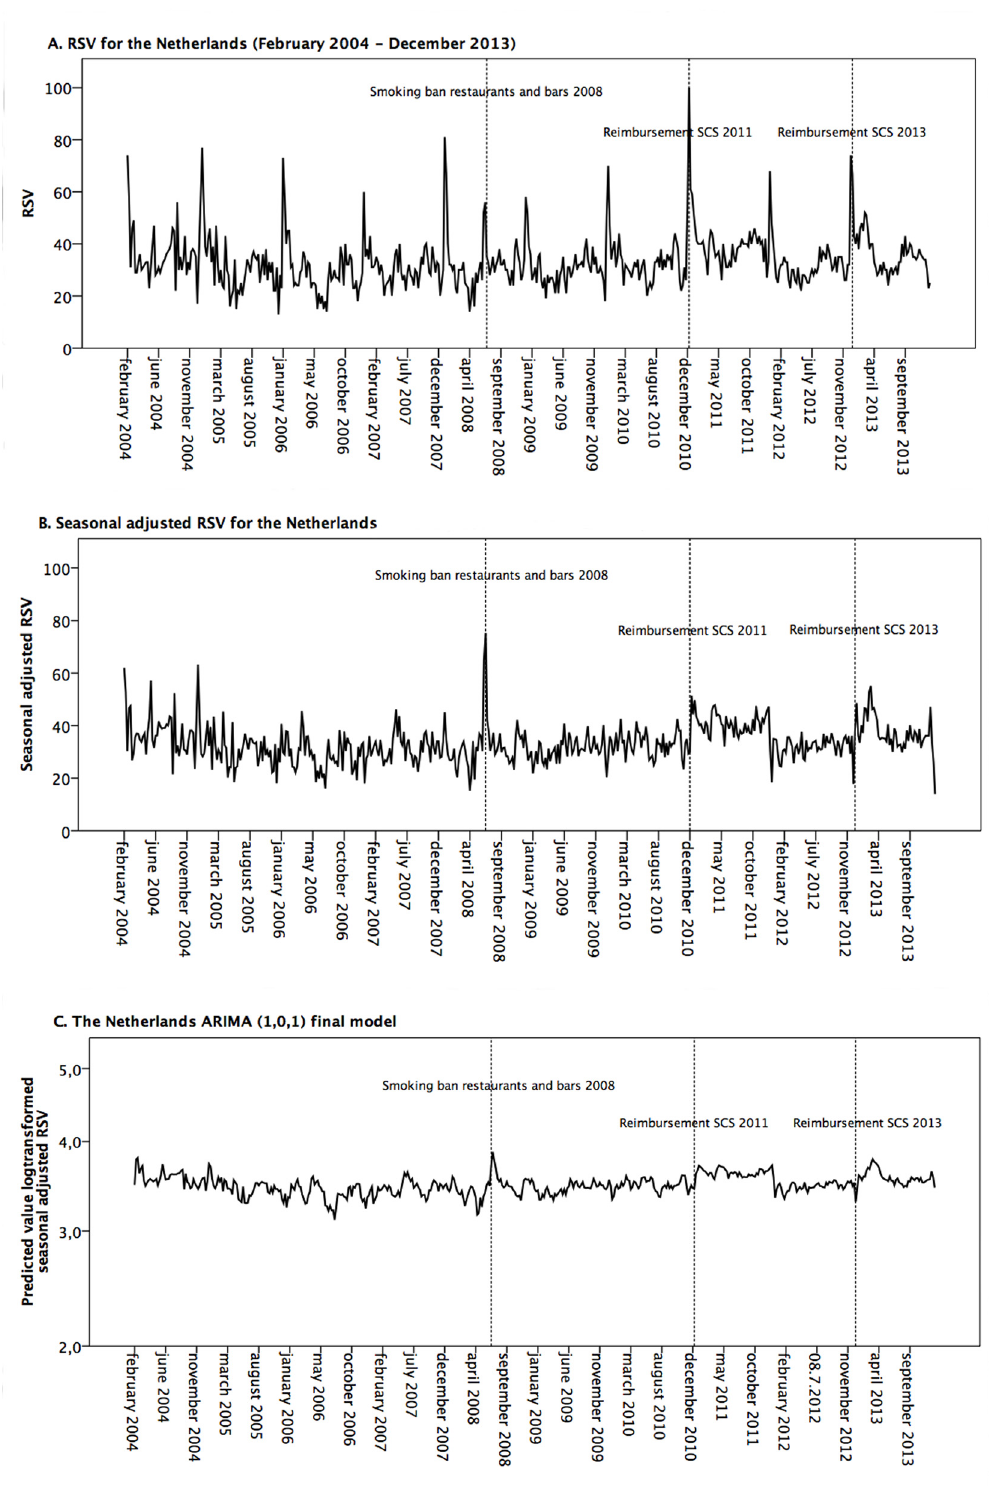
Fig 1. Google Trends RSV data of ‘ quit smoking ’ for the Netherlands. Dutch RSV (A), Dutch seasonally adjusted RSV (B) and as ARIMA (1,0,1) model